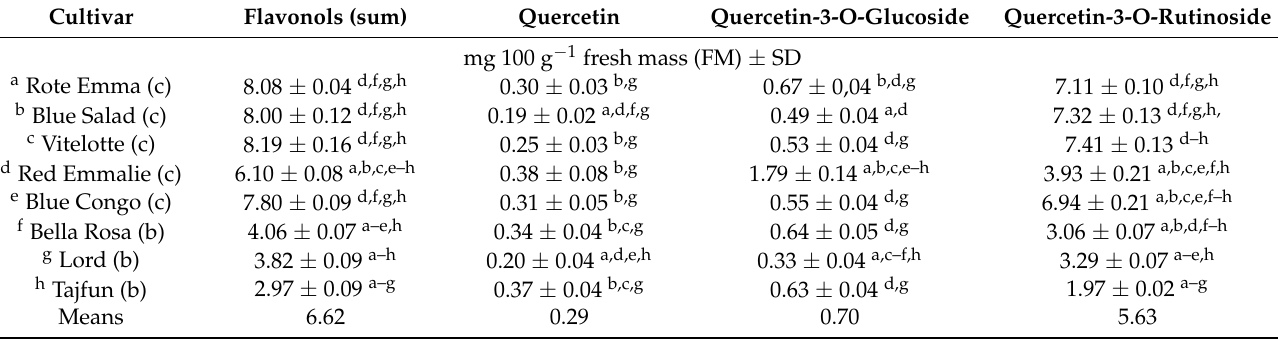
Table 3. Flavonol content in coloured and bright-fleshed potato tubers (mg 100 g − 1 FM).